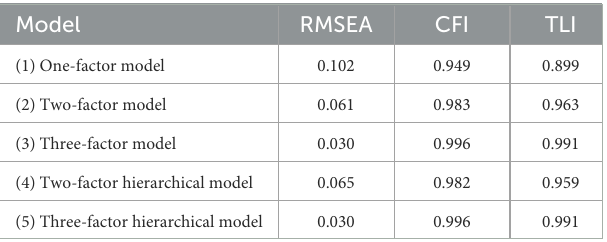
TABLE 2 Summary of model fit in Study 1. TABLE 3 Summary of model fit in Study